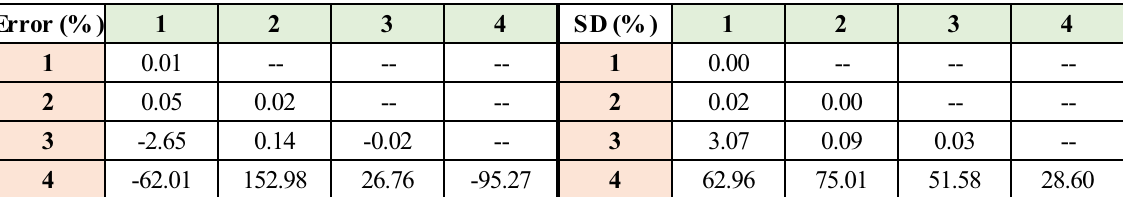
Figure 2. P0 Scattering Matrix Error, MCS vs. SERPENT 2.